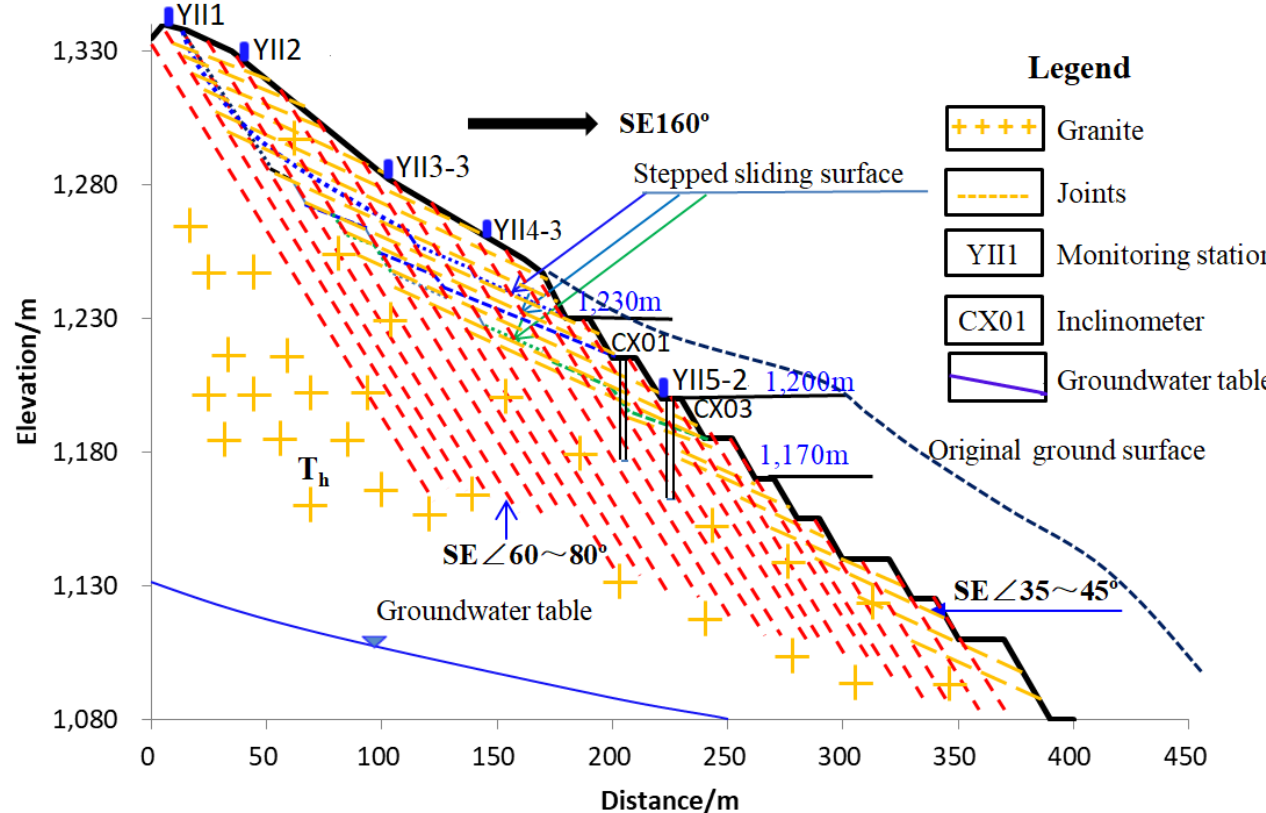
Figure 2. Stratigraphic profile of the cut-slope.